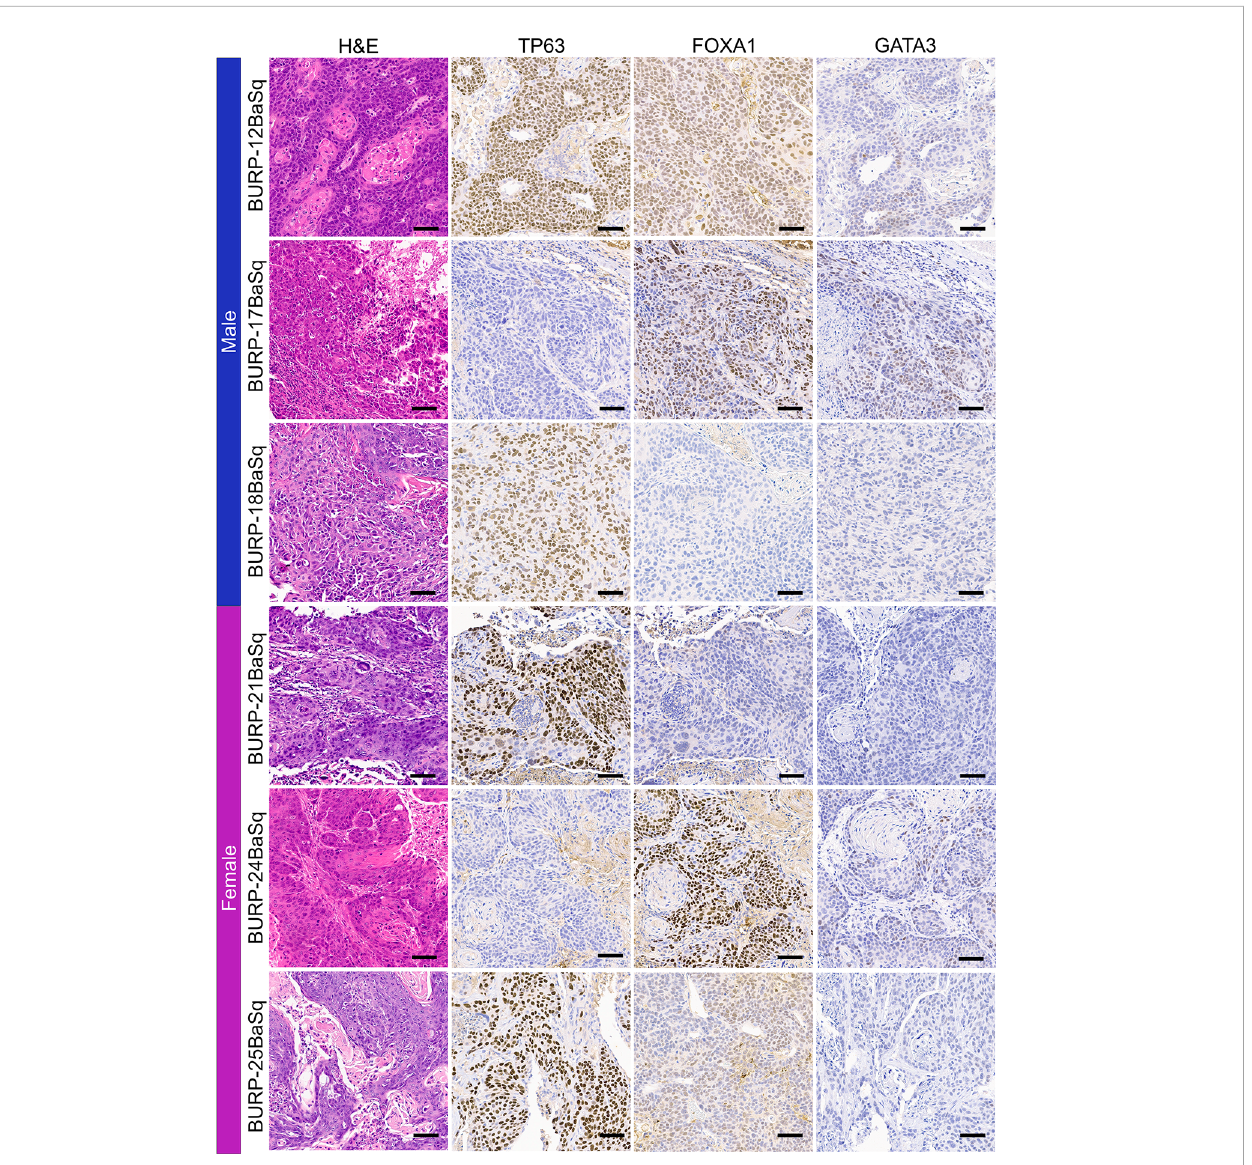
FIGURE 4 IHC of differentiation markers in the BURP lines with Ba/Sq molecular subtype. Serial sections of BURP-12, -17, -18, -21, -24, -25 were stained with H&E, TP63 IHC, FOXA1 IHC, and GATA3 IHC. Blue bar indicates male models and pink bar indicates female models. Scale bar is